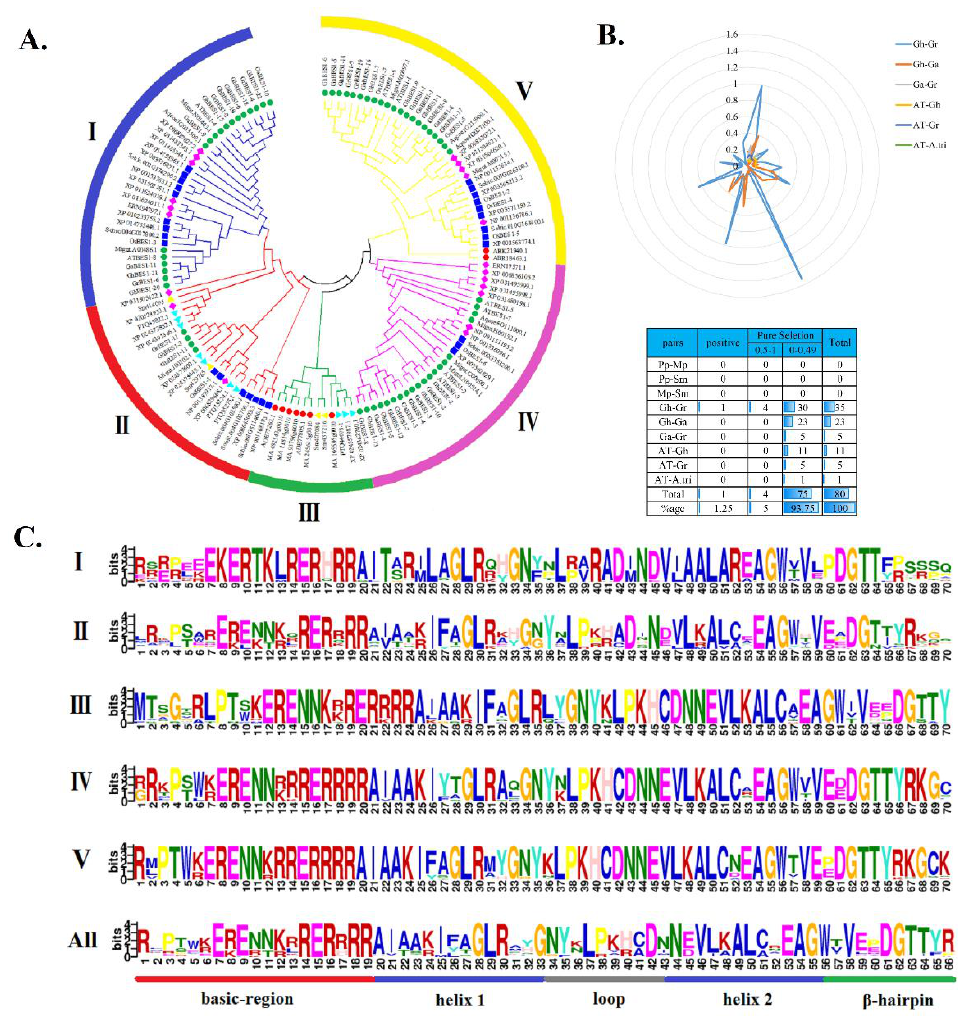
Figure 1. Phylogenetic tree, Ka/Ks values, and sequence features of BES1 . ( A ) Phylogenetic tree of 135 BES1 genes from 17 species. The ML method was adopted to construct the trees. Bootstrapping was performed 1000 times to gain support values for each branch. ( B ) Prediction of duplicated gene pairs involved in different combinations from the table shows the Ka/Ks ratio statistics of different genes. ( C ) The weblogo represents motifs of BES1 protein sequences.